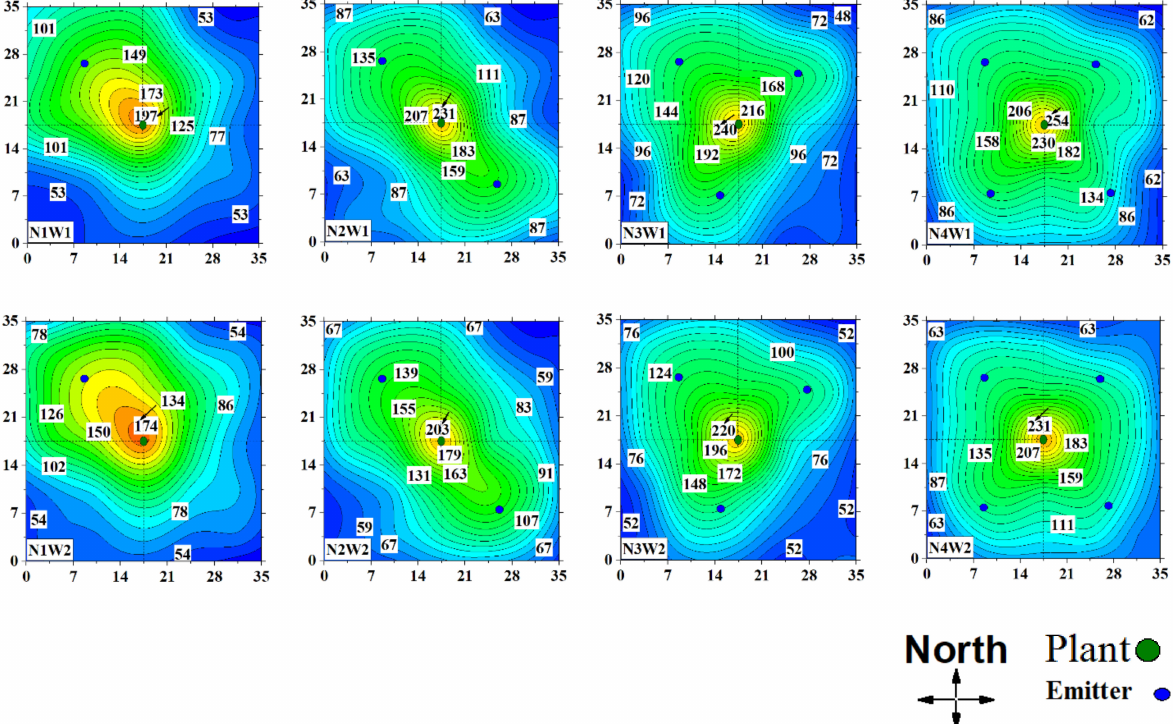
Figure 7. Effects of emitter density and irrigation levels on horizontal, vertical root weight density (RWD, µ g cm − 3 ) distribution for the fall-winter cropping season (at the end of the cropping season; the maximum value is marked by a solid